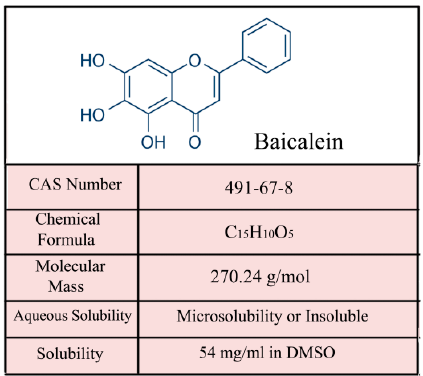
Figure 1. The chemical structure and major properties of baicaelin (5,6,7-trihydroxyflavone). CAS, chemical abstracts service; DMSO, dimethyl sulfoxide.